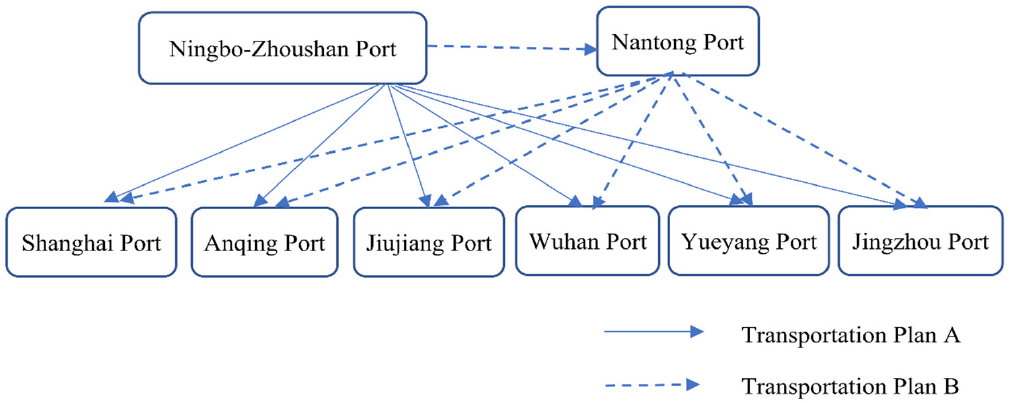
Figure 2. Crude oil transportation scheme in the Yangtze River Basin.